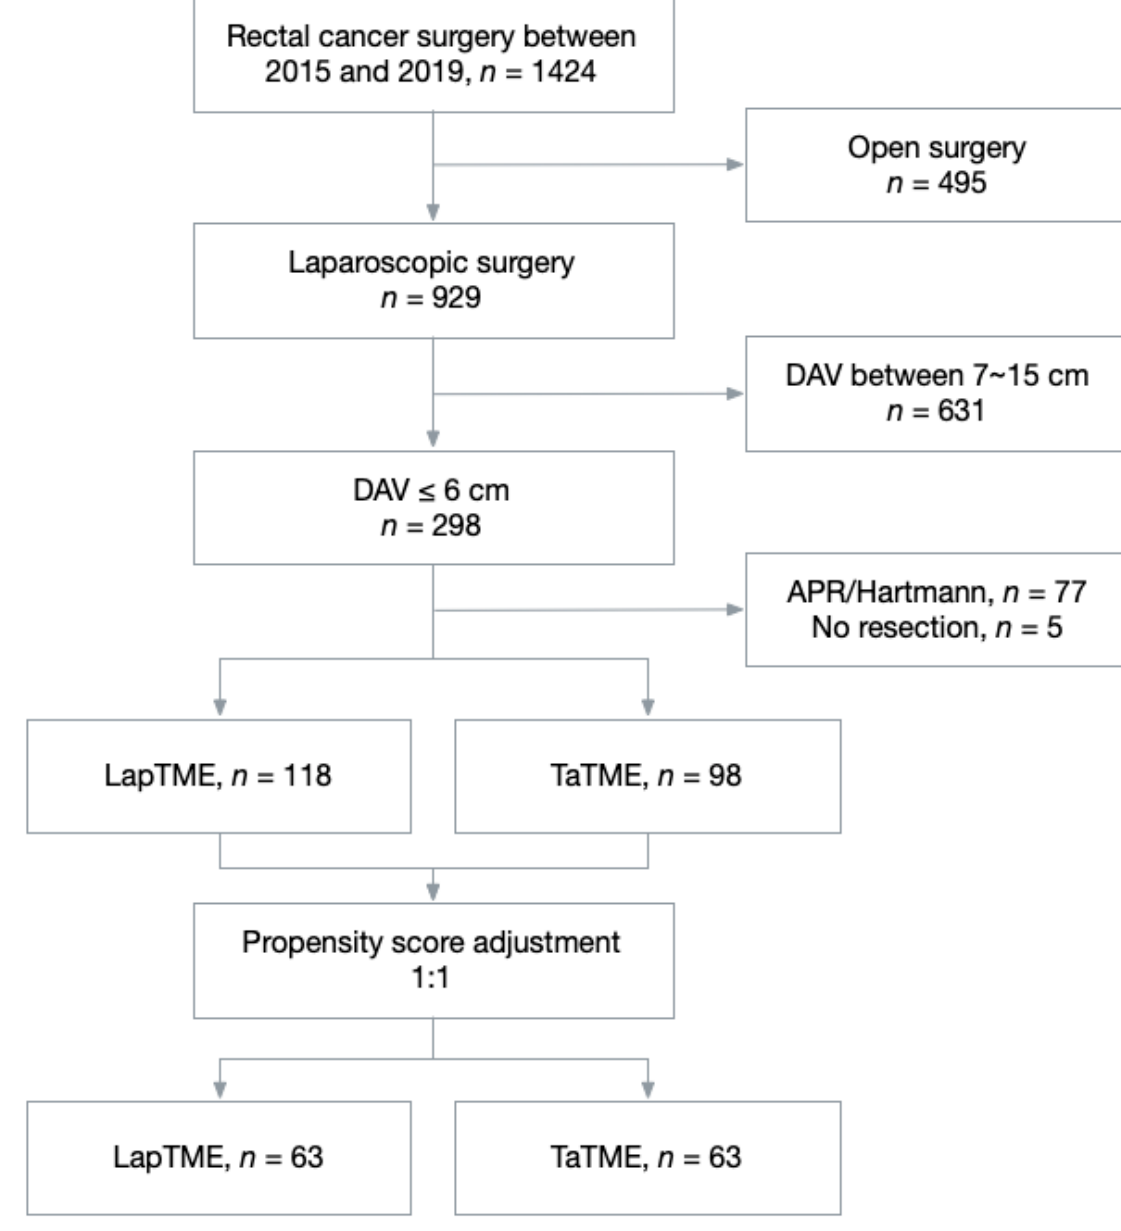
Figure 1. The flowchart illustrating the clinical patient selection in this study.